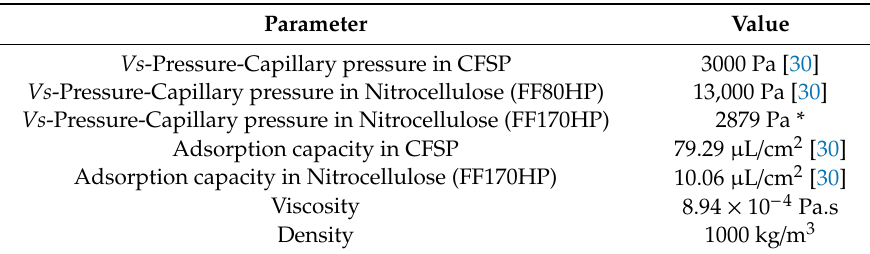
Table 2. List of constant values used in the